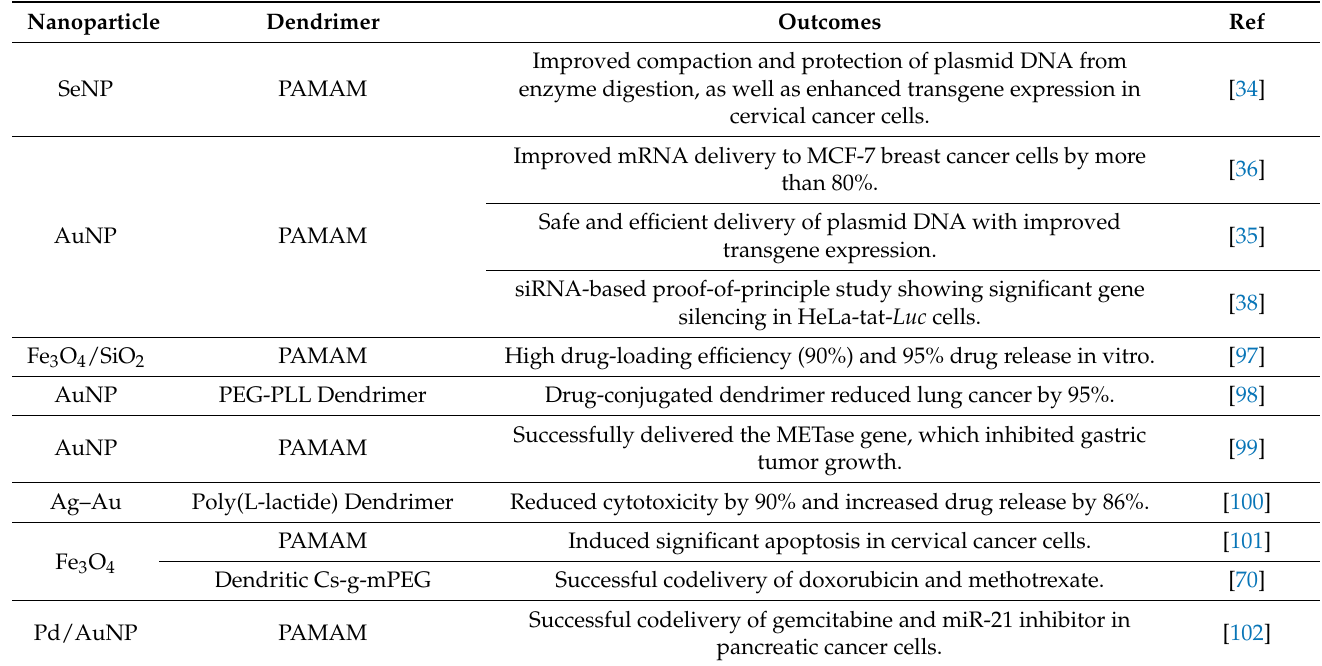
Table 1. Summary of dendrimer-modified inorganic nanoparticles in gene and drug